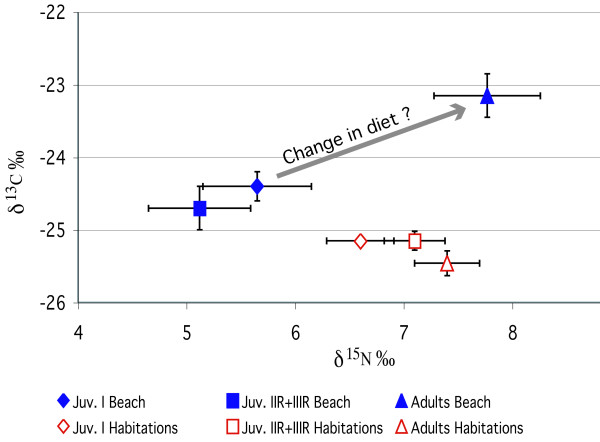
Carbon and nitrogen stable isotopes (δ13C and δ15N). Mean ratios measured on the cuticle of juvenile and adult mole cricket forelegs collected on the Awala-Yalimapo beach and from garbage at habitations. Mean ± Standard Error.